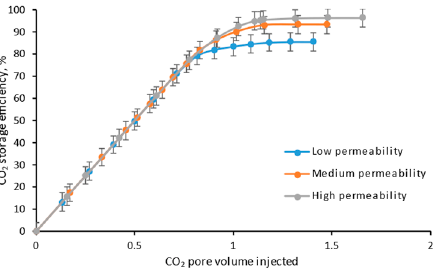
Figure 16. Relation curves between long core CO 2 storage efficiency and injection volume under different permeabilities.